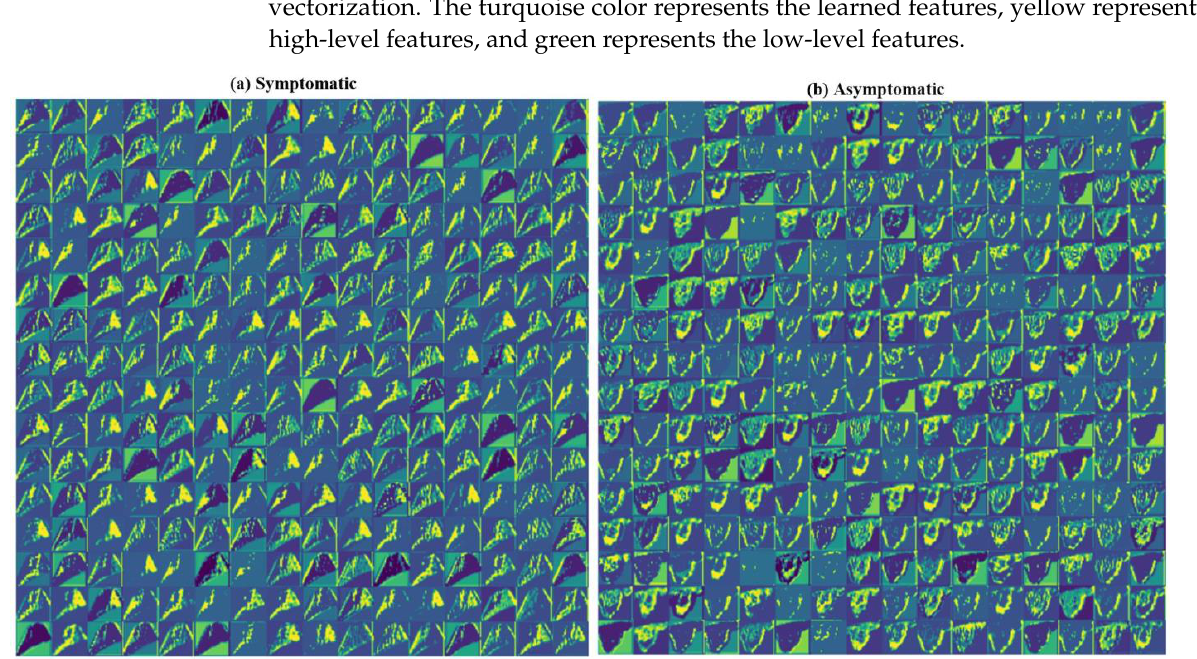
Figure 14. Visualization of the intermediate layers of SuriNet on the ( a ) symptomatic class and ( b ) asymptomatic class.